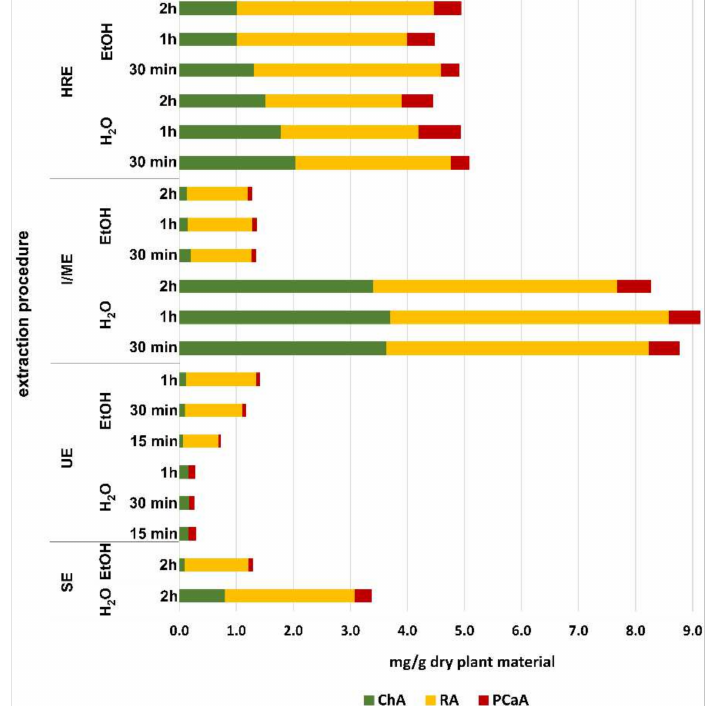
Figure 2. Sum (mg/g dry plant material) of determined phenolic acids: chlorogenic acid (ChA) and rosmarinic acid (RA) in water and ethanol extracts from dried aerial parts of G. hederacea L., prepared by different extraction methods. Abbreviations: HRE—heat reflux extraction; UE—ultrasound- assisted extraction; SE—extraction in the Soxhlet apparatus; I/ME—extracts prepared by pouring boiling solvent followed by maceration for 30 min, 1 h or 2 h at room temperature.